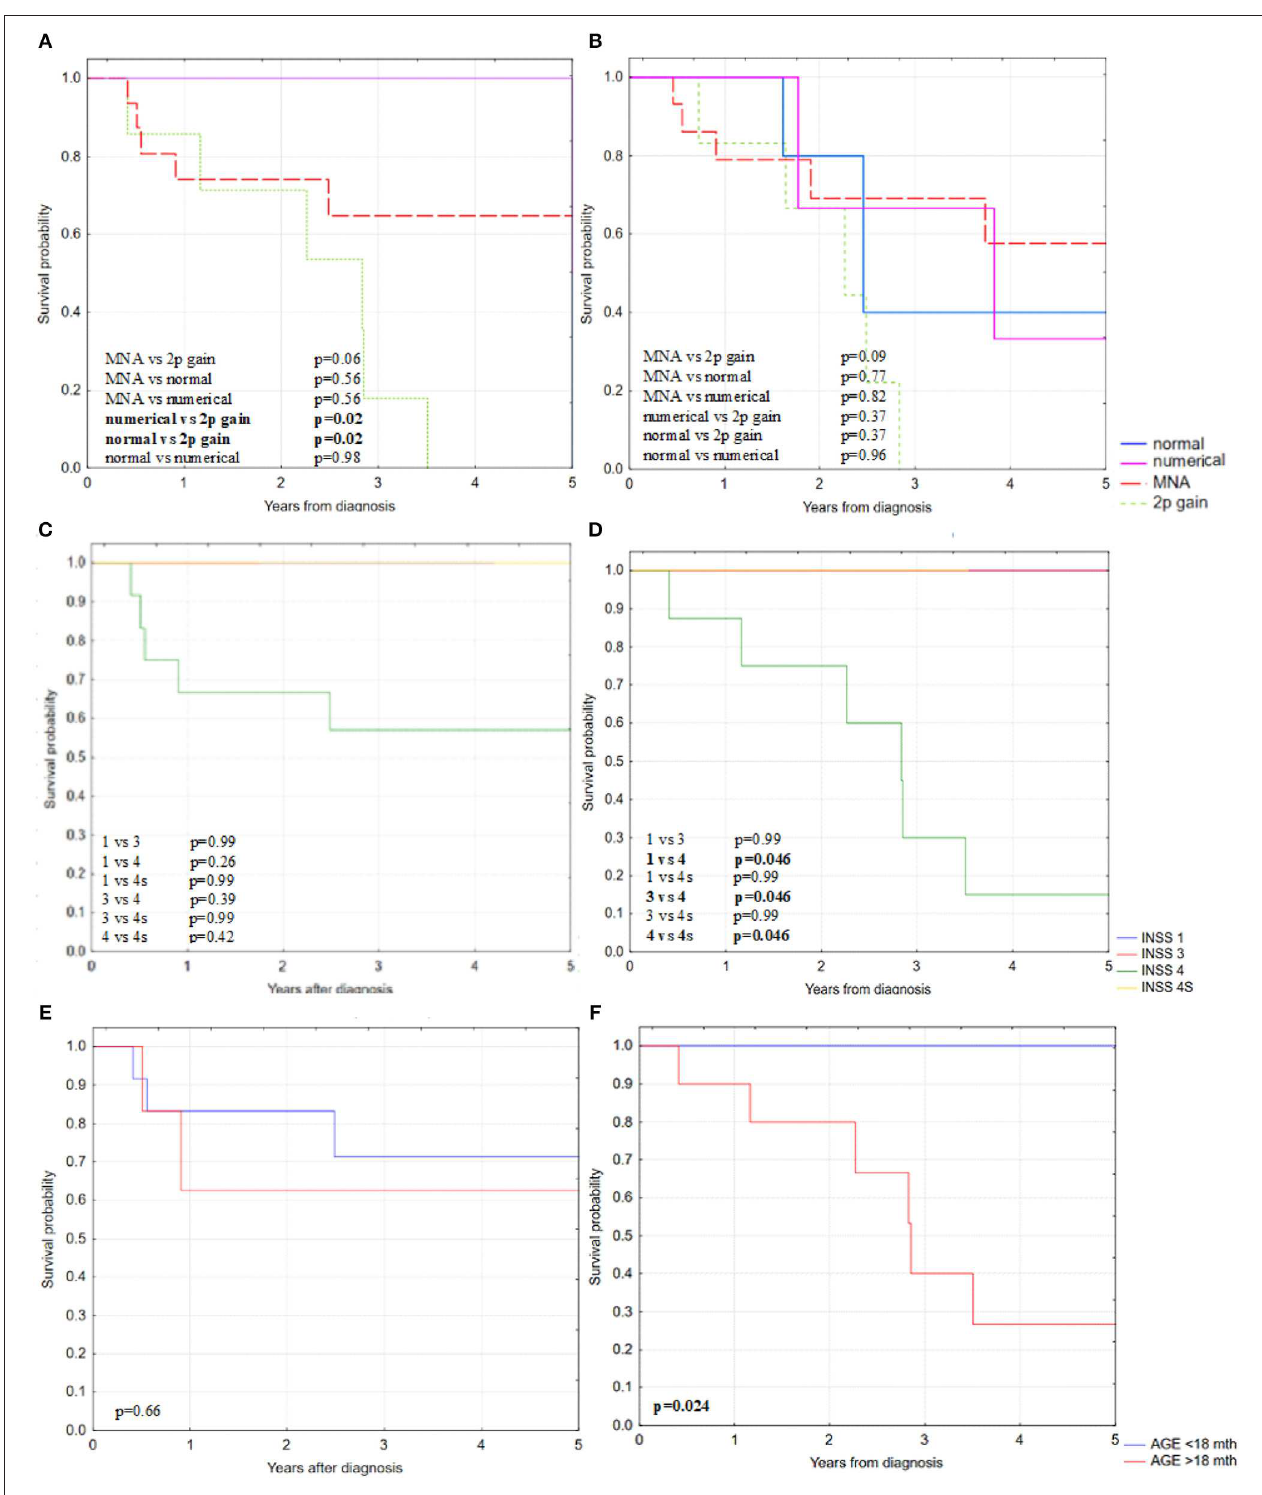
FIGURE 3 | Kaplan–Meier estimates of (A) 5-OS and with statistically significant differences in high-risk disease group of NB patients and (B) 5-EFS without statistically significant differences between specific subgroups in relation to copy number status of MYCN gene in high-risk disease group of NB patients; (C) 5-OS in MNA subgroup and (D) 5-OS in 2p gain subgroup in relation to disease stage; (E) 5-OS in MNA subgroup and (F) 5-OS in 2p gain subgroup in relation to patients age.